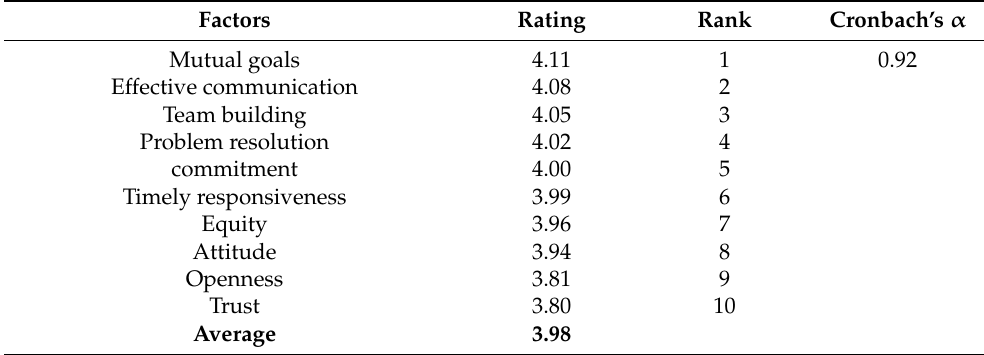
Table 2. Partnering among project participants.